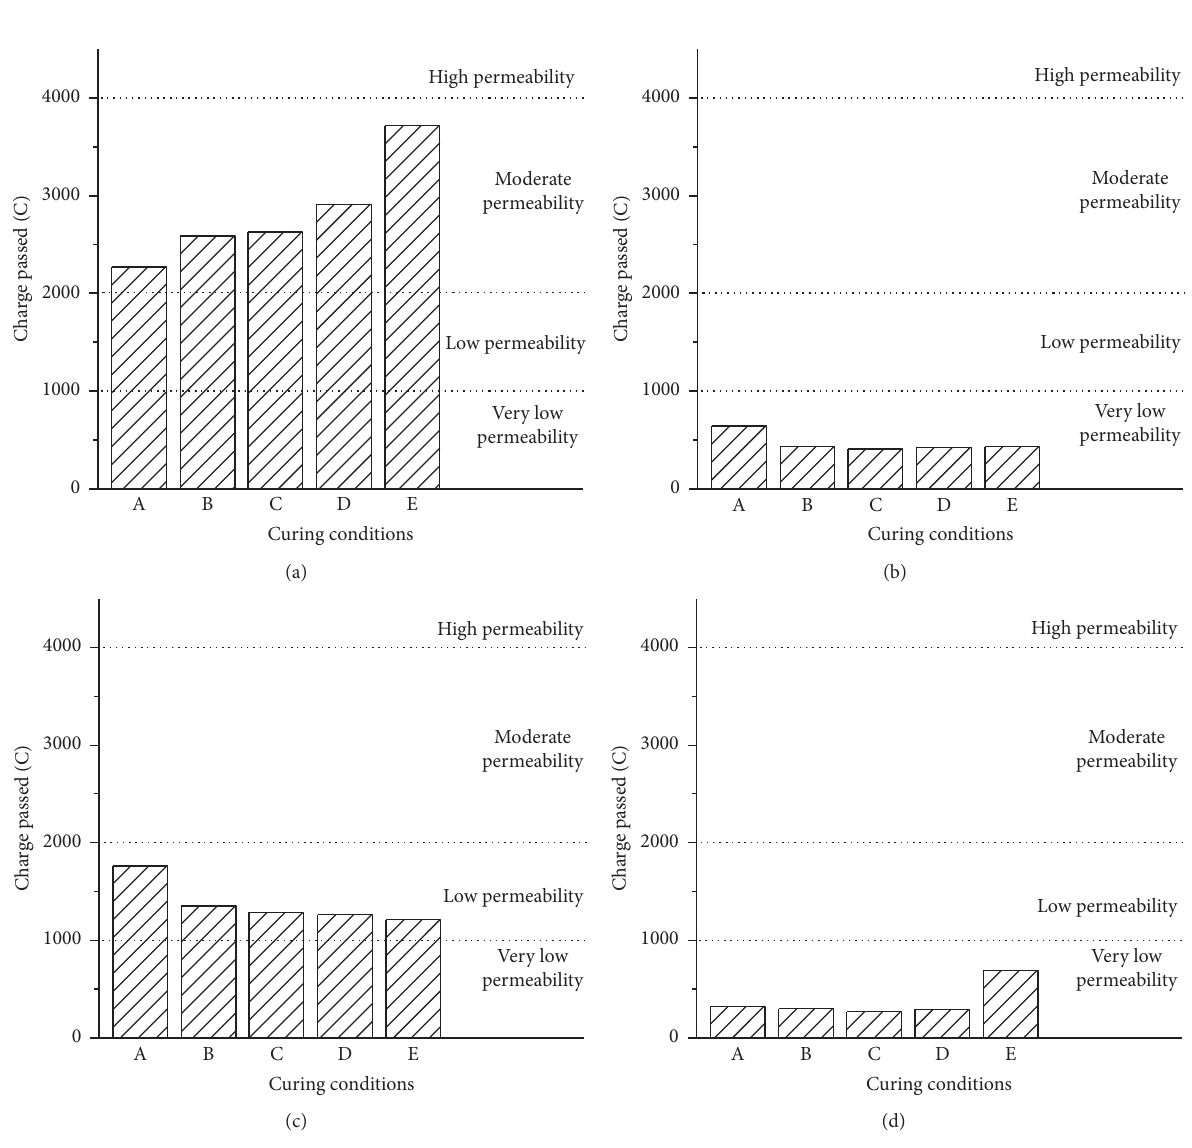
Figure 6: The chloride ion permeability of concrete at the age of 90 days. Samples: (a) plain cement, (b) 45% FA, (c) 45% GGBS, and (d) 12%